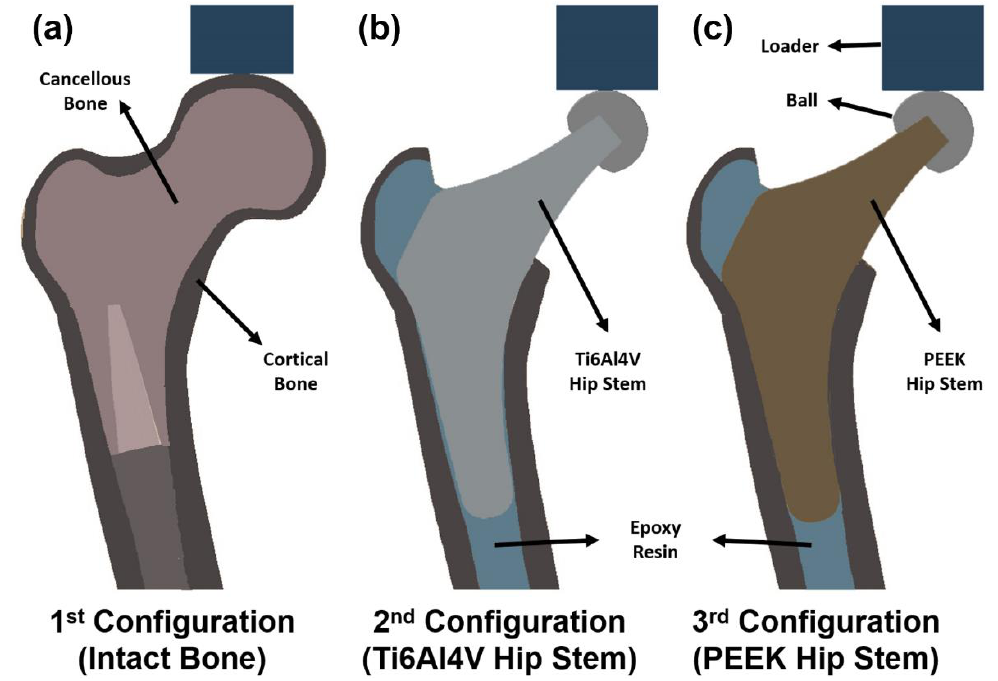
Figure 3. Section view schematic of (a) intact femur model as 1st configuration, (b) implanted hip stem femur model as 2nd configuration, and ( c ) implanted PEEK hip stem femur model as 3rd Ti6Al4V hip stem femur model as 2nd configuration, and (c) implanted PEEK hip stem femur model as 3rd configuration.